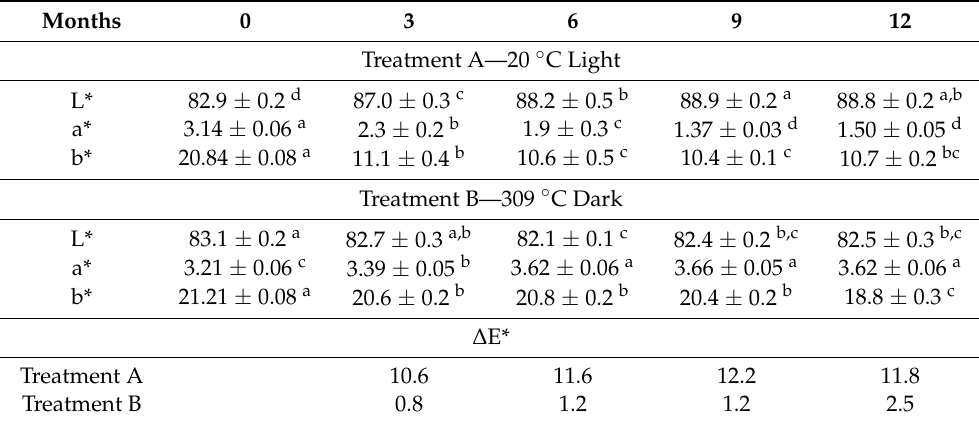
Table 1. Color evolution during the ageing ( n = 5 points in triplicates).